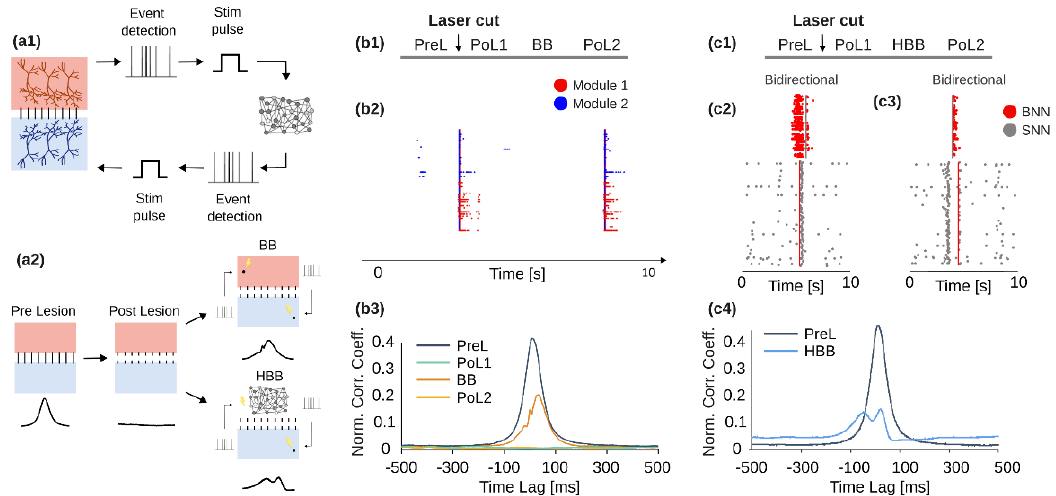
Figure 2. Demonstrator of an in vitro neuromorphic prosthesis. ( a1 ) Scheme of the bi-directional interface between the biological neural network—BNN (i.e., a bi-modular culture of biological neurons over a micro-electrode array—MEA) and the spiking neural network—SNN. The actual system is composed by the commercial amplifier, hosting the MEA with the culture, and the hardware board to perform the closed-loop real-time processing (i.e., spike detection and event detection) of the biological signals. ( a2 ) The cartoon of a biological bi-modular culture over a MEA is reported ( left ). A focal lesion is performed to cut the connections between the two modules ( center ). Two are the possible reconnection strategies: the Bidirectional Bridging—BB ( top right , used when the connection between the two modules is lost) and the Hybrid Bidirectional Bridging—HBB ( bottom right , used when, after the lesion, one of the two modules is not functioning anymore, and thus it exploits an artificial spiking neural network—SNN). ( b1 ) Schematic of the BB experimental protocol: after the first phase of basal activity (PreL), a laser cut (i.e., the lesion) was performed. Then, spontaneous activity was recorded again (PoL1), followed by the BB strategy and a final phase of spontaneous activity (PoL2). ( b2 ) A 10-s raster plot of the network bursting activity of one representative experiment during a BB phase. ( b3 ) The cross-correlation (CC) function for one representative experiment during the four phases of the experiment (different colors). ( c1 ) Schematic of the HBB experimental protocol: after the first phase of basal activity (Pre-Lesion—PreL), a laser cut (i.e., the lesion) was performed. Then, spontaneous activity was recorded again (Post Lesion1—PoL1) followed by the HBB strategy and a final phase of spontaneous activity (Post Lesion2—PoL2). ( c2 ) Raster plot of a spontaneous network burst in the BNN which triggers a stimulation to the SNN, which generates a network burst and a stimulation back to the BNN. ( c3 ) Opposite situation with respect panel ( c2 ): a spontaneous network burst is first generated in the SNN ( right ). ( c4 ) CC function for one representative experiment during preL and HBB phases (different colours). Modified from